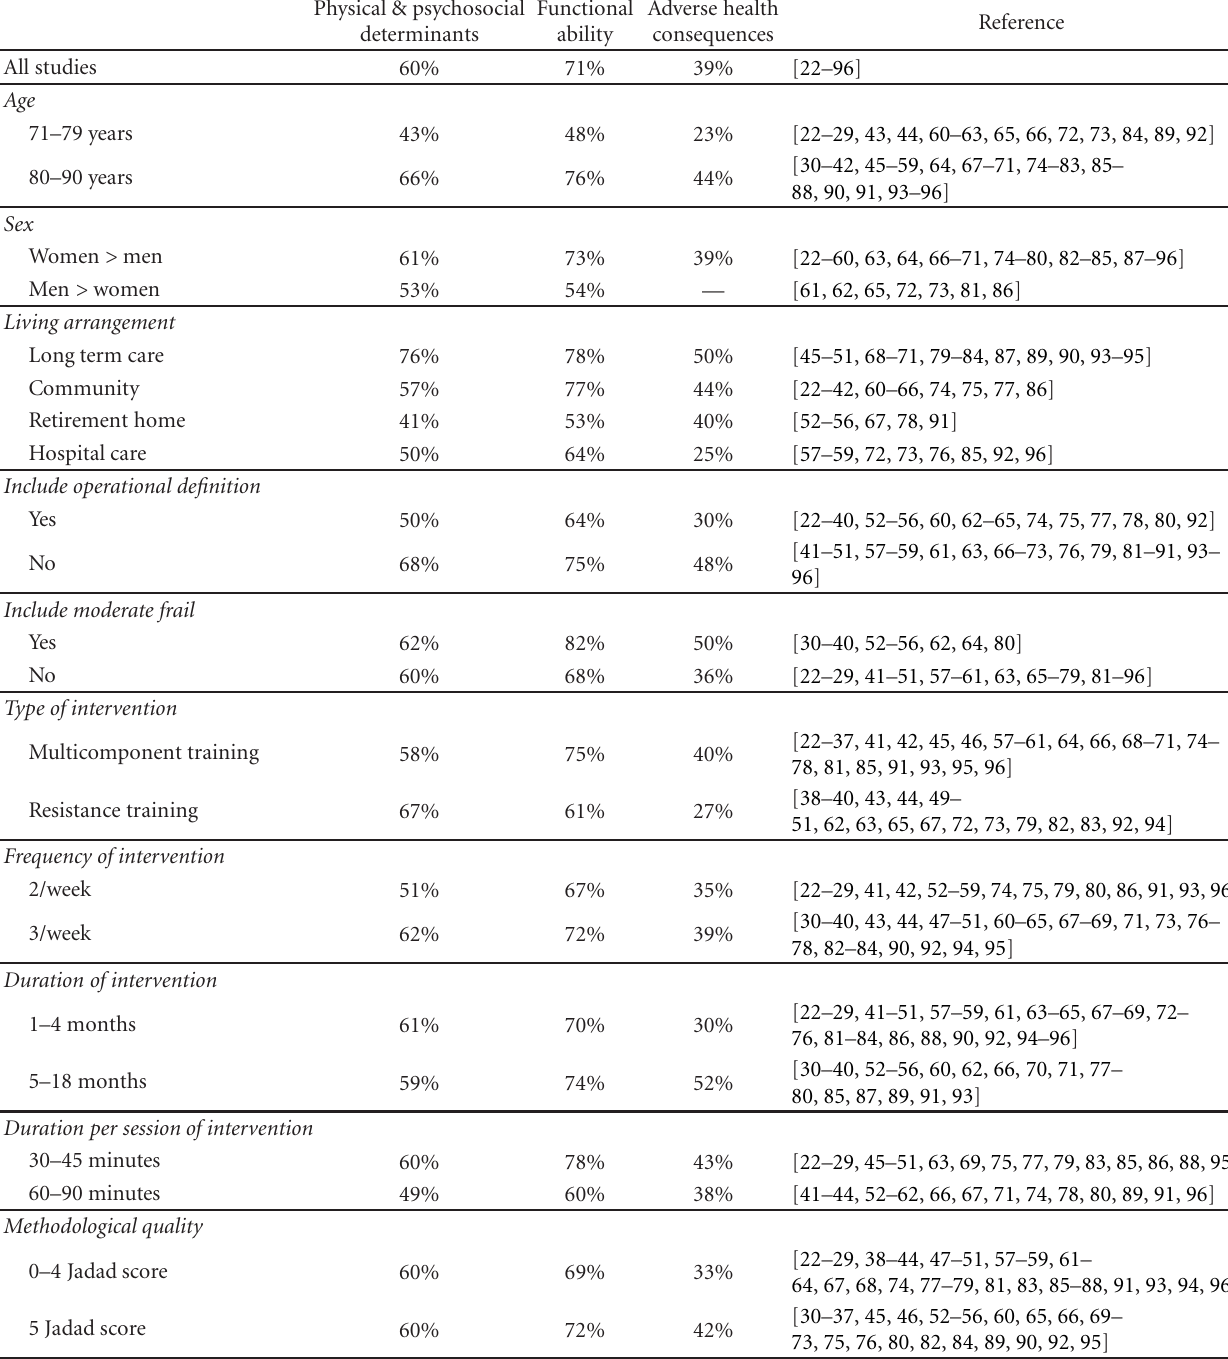
Table 5: Percentage of outcome measures that improved due to the exercise